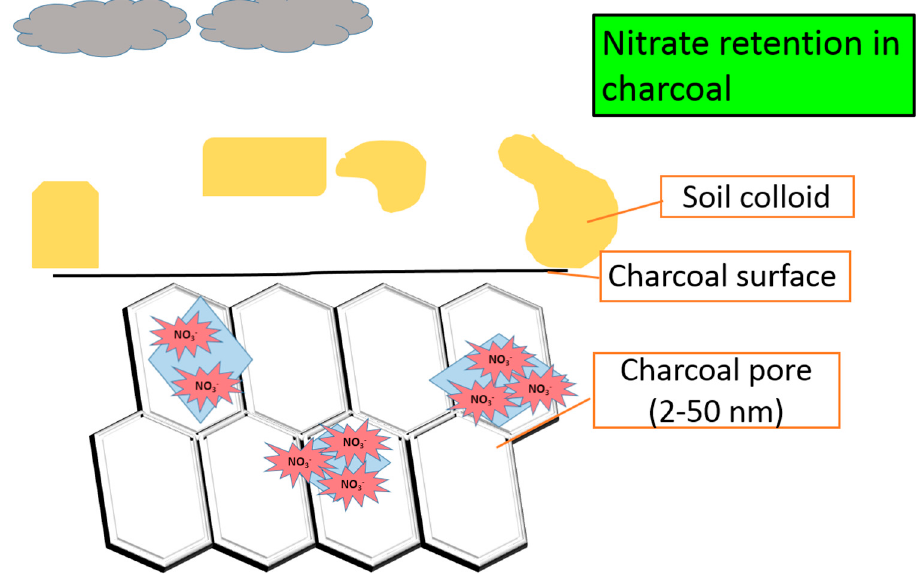
Figure 3. Schematic illustration of the entrapment of nitrate in soil water inside charcoal pores.